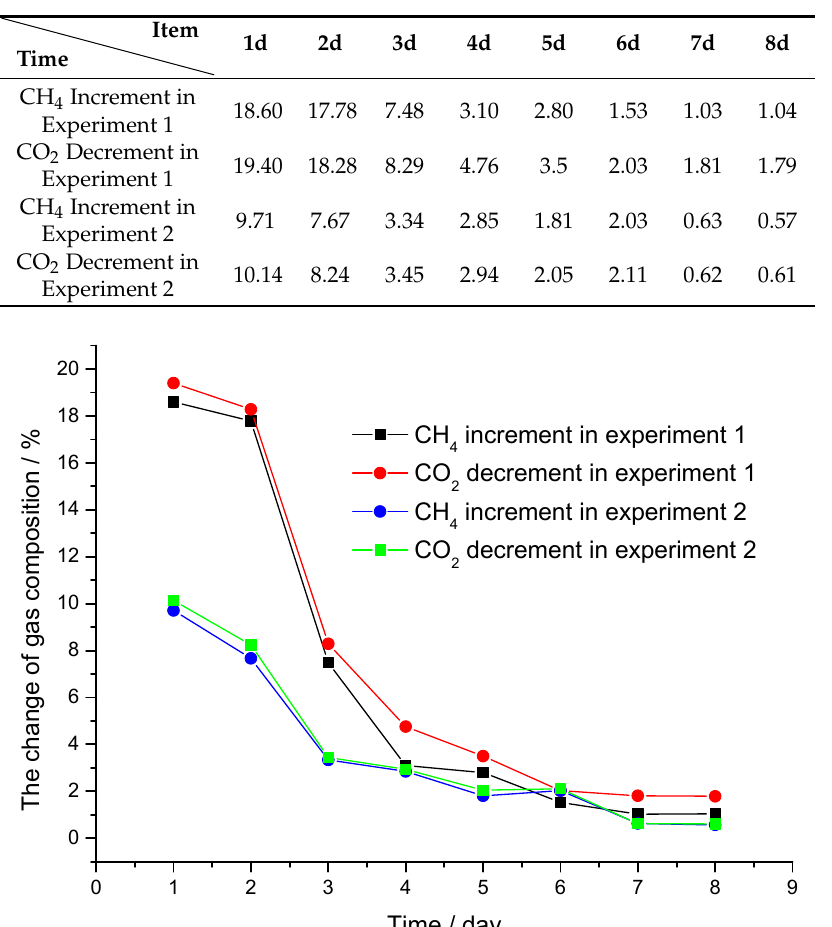
Table 1. The increment of CH 4 fraction and the decrement of CO 2 fraction in the collected gas samples in experiment 1 and experiment 2.